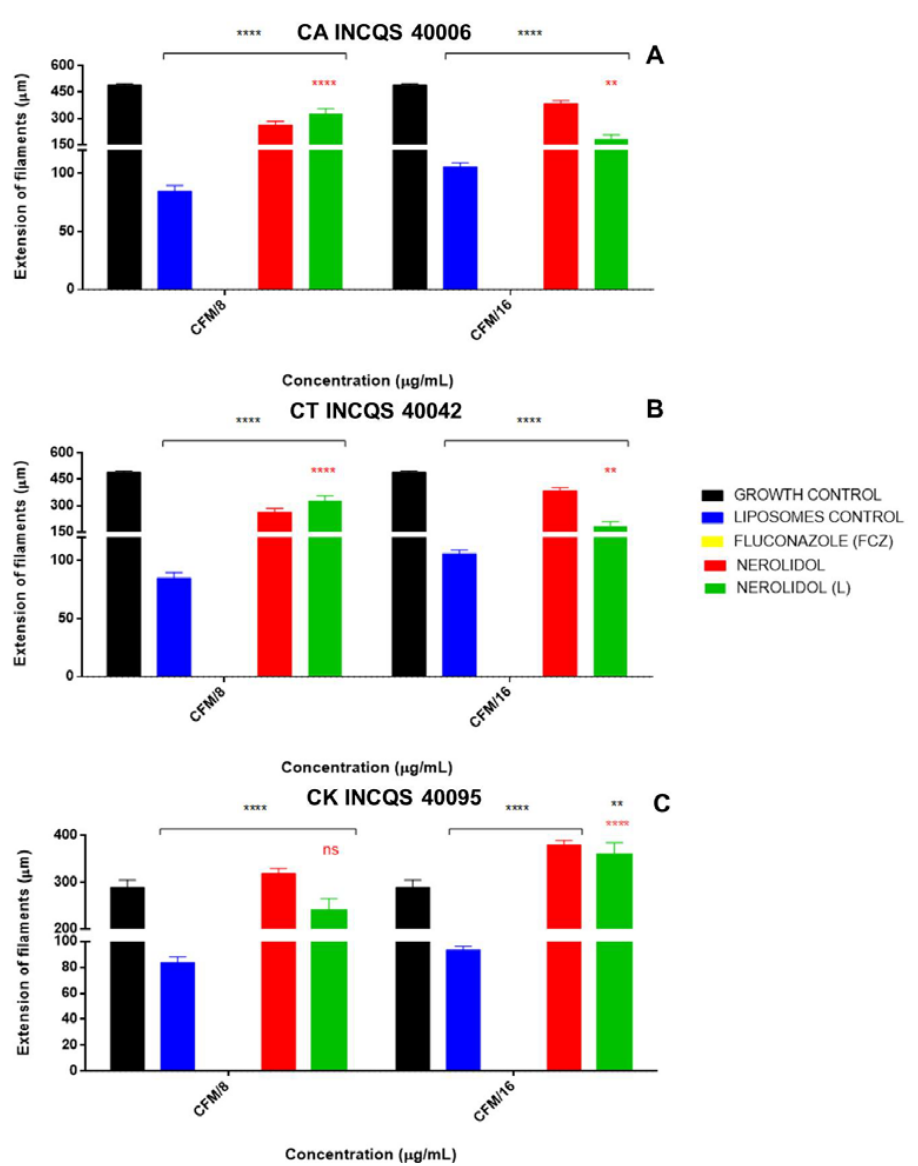
Figure 3. Effects of the in vitro treatment with fluconazole (FCZ), nerolidol and liposomal (L) nerolidol on the fungal morphology. Changes in the fungal morphology were expressed as a measure of the extension of filaments. Liposomes without nerolidol were used as controls. ( A ) CA— Candida albicans ; ( B ) CT— Candida tropicalis ; ( C ) CK— Candida krusei ; INCQS—National Institute for Quality Control in Health. p < 0.01 = **, p < 0.0001 = ****. Membranes 2020 , 10 , x FOR PEER REVIEW